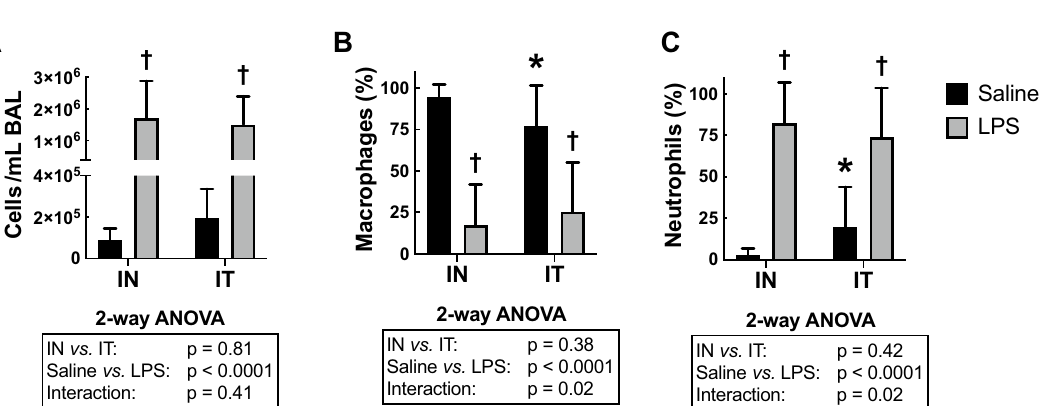
Figure 2. Cellular lung inflammation in the bronchoalveolar lavages. ( A ) Total cells per mL of BAL, and the percentage of ( B ) macrophages and ( C ) neutrophils in BAL are depicted for mice treated with either saline (black) or LPS (grey) through either the intranasal (IN) or the intratracheal (IT) route. The results of the two- way ANOVA are shown at the bottom of each graph. *Indicates statistically significant from the IN-exposed group treated with saline. †Indicates statistically significant from the group treated with saline exposed through the same route. n = 18 per group and the data shown are means ±